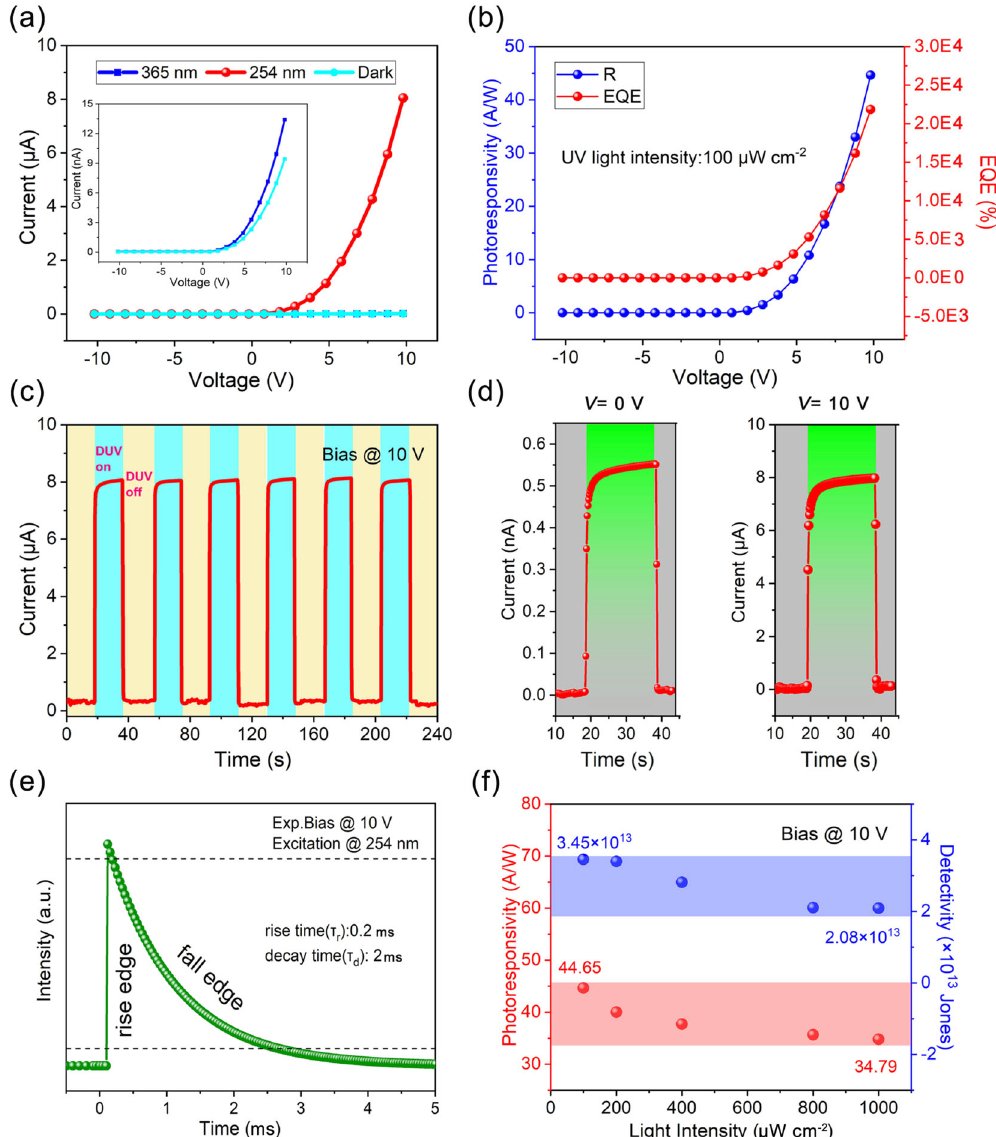
Fig. 6 Characterization of the fully printed UV photodetector founded on Ga 2 O 3 /Si heterojunction. a The linear-scale I – V features in the dark and under 254 nm and 365 nm UV light resources of 100 μ W cm − 2 . b The 254 nm UV light responsibility and the ef fi ciency of external quantum at various implemented voltages. c Reproducible on/off switching of photodetector cell under 254 nm light at 10 V. d Time-resolved photocurrent assessments under laser resources. The green-shaded areas exhibit laser illumination for 20 s. e Time response of Ga 2 O 3 /Si photodetector. f Photoresponsivity and photodetectivity as a function of the great intensities at 10